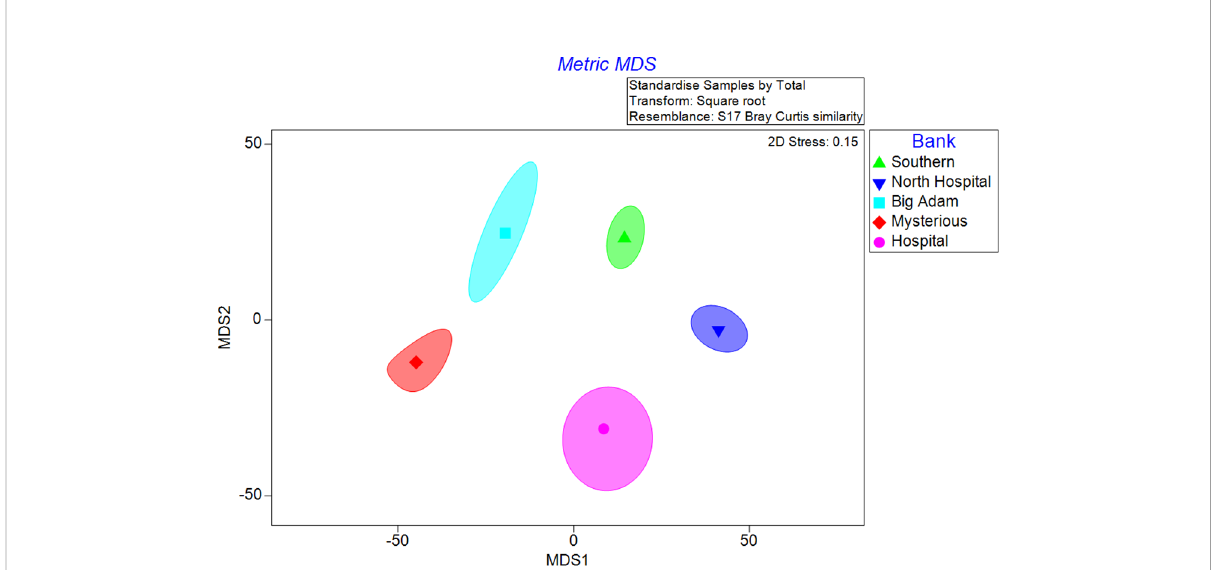
FIGURE 3 Two-dimensional metric MDS plot comparing percent cover of mesophotic benthic communities on fi ve South Texas Banks. Points represent the group averages of the square root transformed samples. The contours represent nominal 95% bootstrap regions generated from 150 bootstrap averages for each Bank.